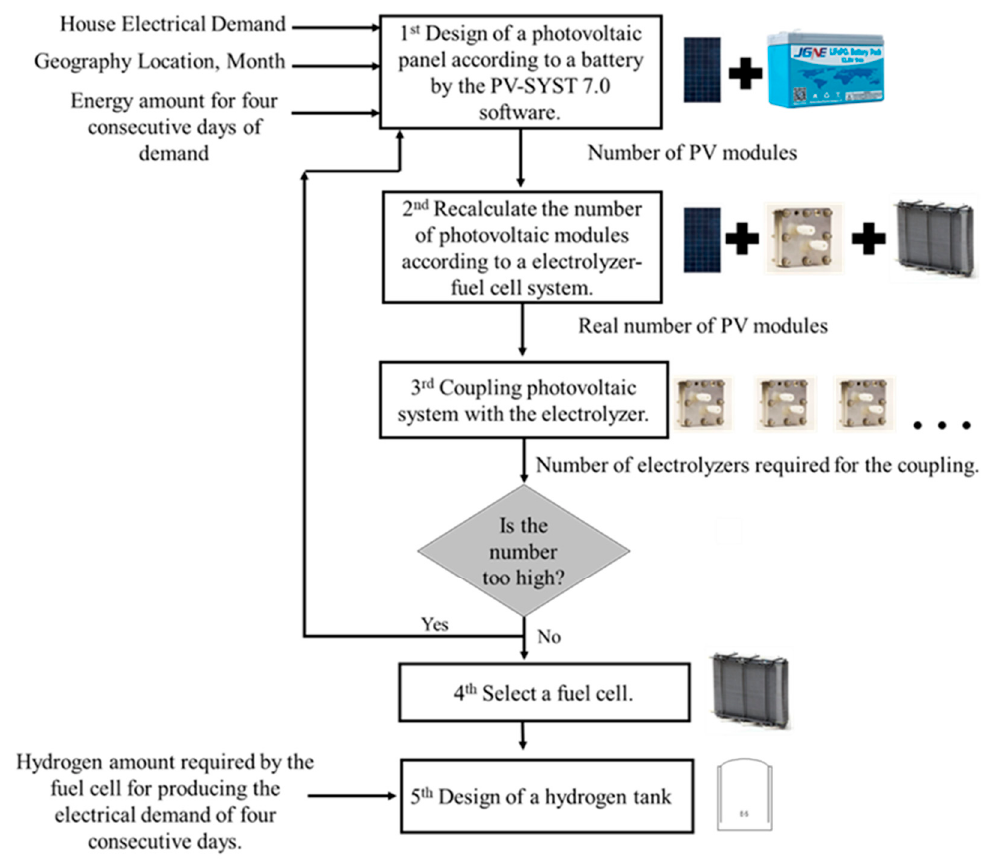
Figure 2. Flowchart of design.